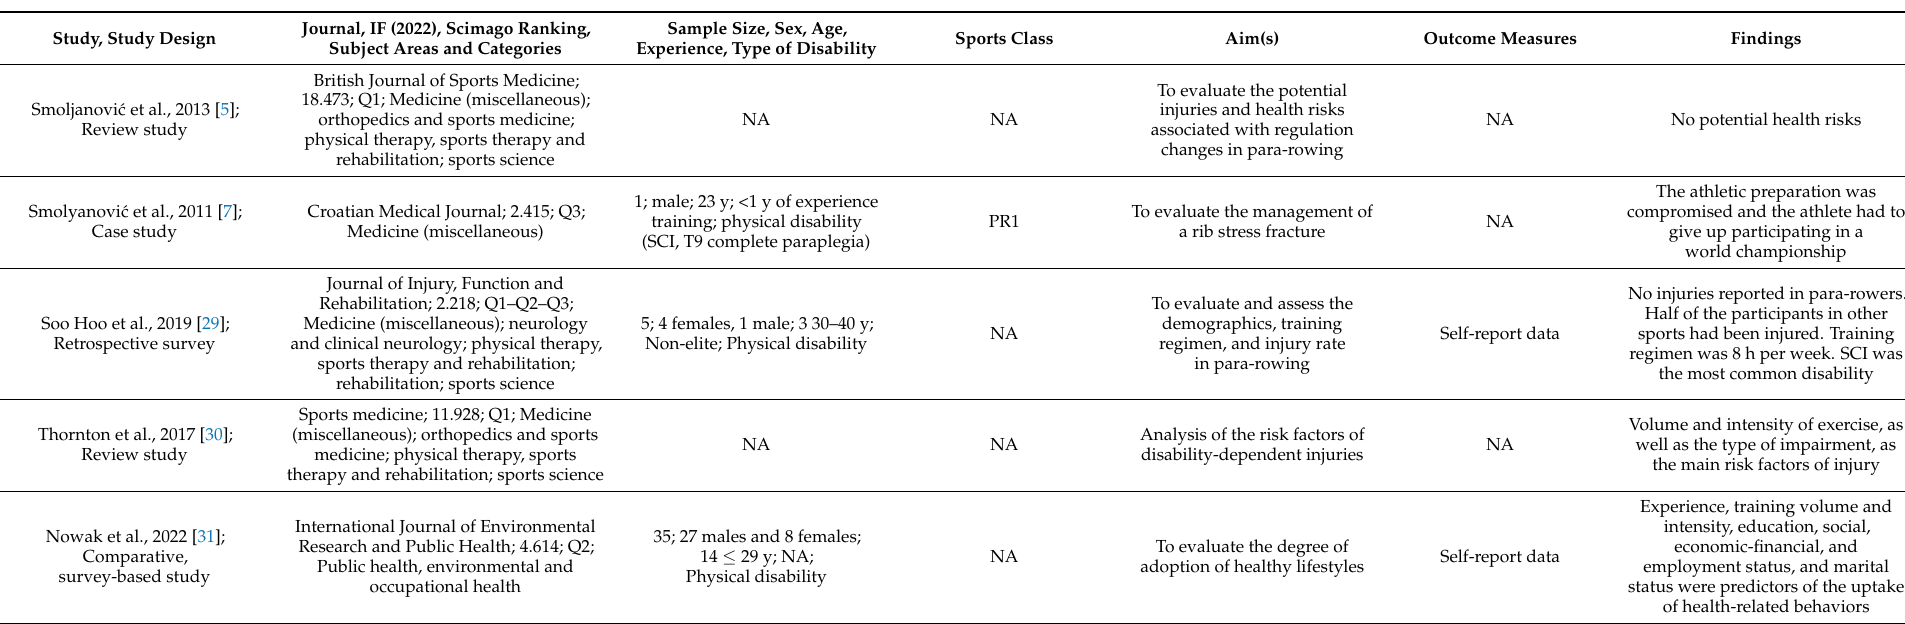
Table 2. Main characteristics of the study included in the present scoping review concerning health, injuries, and risk factors in para-rowing. Abbreviations: IF (Impact Factor); NA (not available); SCI (spinal cord injury); y